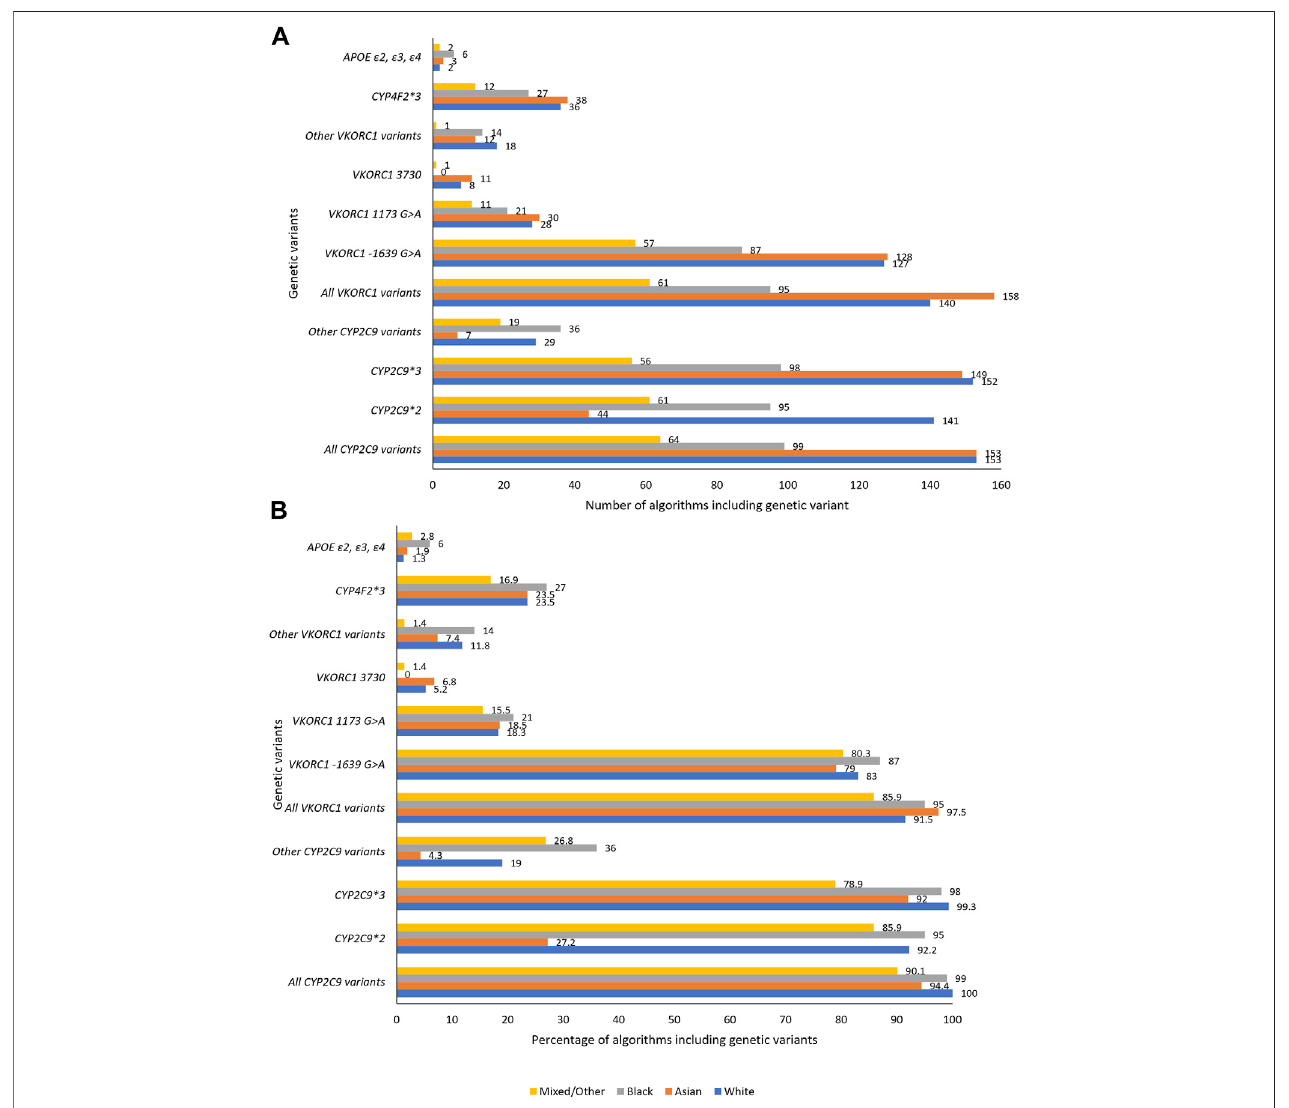
FIGURE3| Geneticvariablesincludedinthepharmacogenomicalgorithms. A,B ,respectively,showthenumberandpercentageofpharmacogenomicalgorithms including a speci fi c genetic variant. APOE , Apolipoprotein E; CYP , Cytochrome P450; VKORC1 , Vitamin K epoxide reductase complex subunit 1.